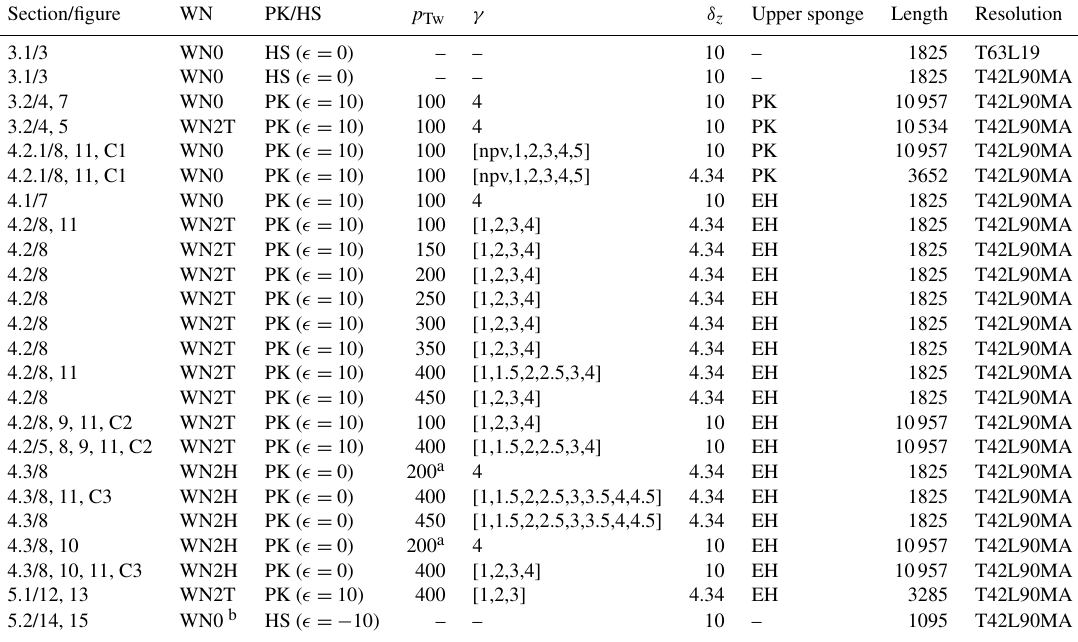
Table B1. List of all simulations presented in this study, with information on all relevant parameter settings and variations, and simulation length in days (see text for details). Simulations with multiple values of γ are listed in one row for brevity. a Also p Ts = 200hPa. b Including additional localized heating with parameter settings given in Sect.